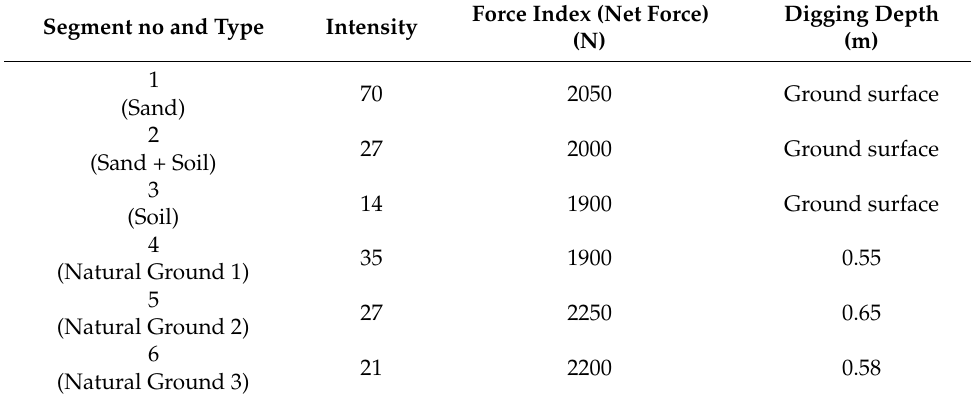
Table 3. Intensity and force index (net force) values for each